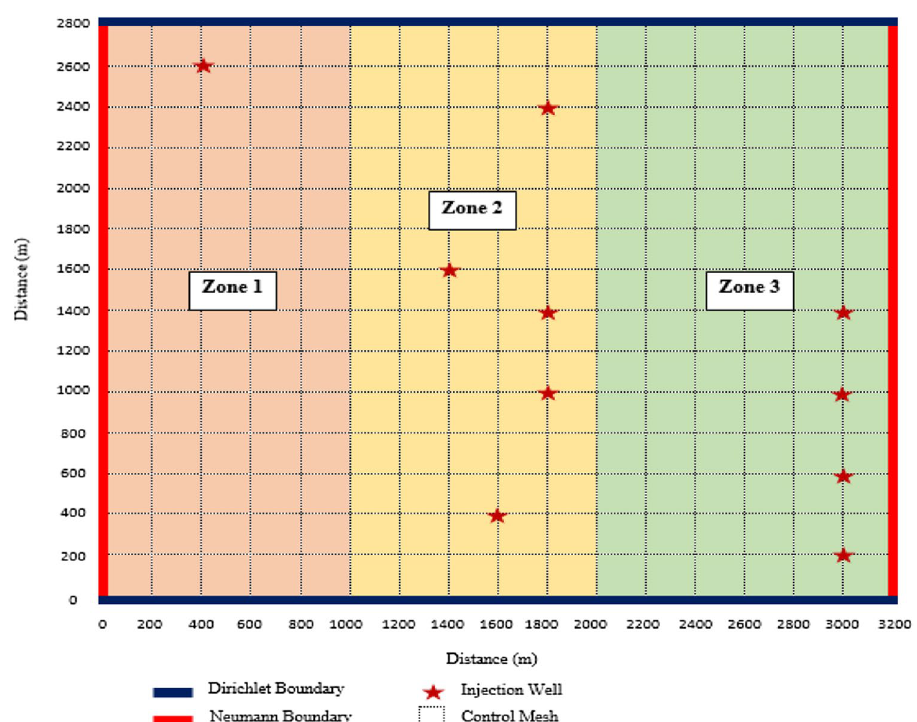
Fig. 9 Optimal location of injection wells under scenario 2